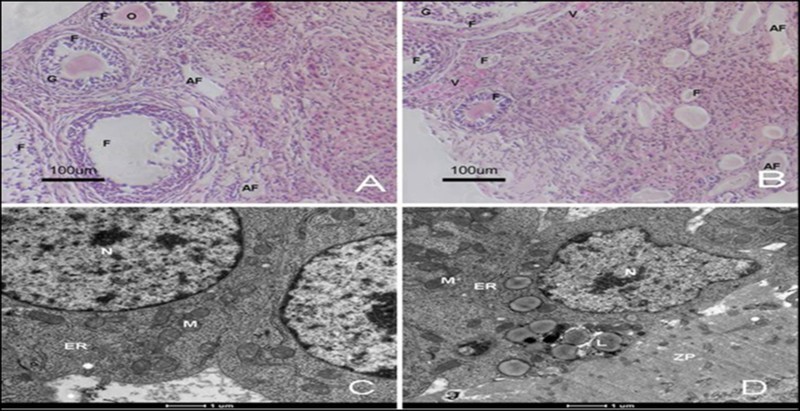
Structure of ovary and ultrastructure of cumulus in treated and control mice. HE staining showed that different stages of follicles were present in ovaries from treated (A) and control (B) mice. The ultrastructure of cumulus cells was observed by SEM (C and D); many diploids were assembled in cumulus cells from treated mice (D). F: follicle, G: granule, O: oocyte, V; vasculature, AF: atretic follicle, L: lipid droplet, N: nucleus, M: mitochondrion, ER: endoplasm reticulum.